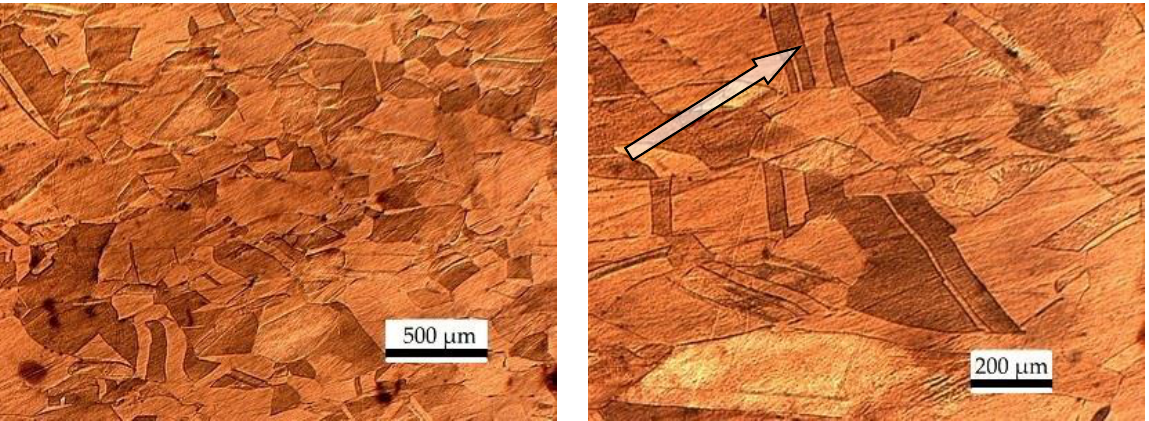
Figure 7. Microstructure of a non-deformed specimen.